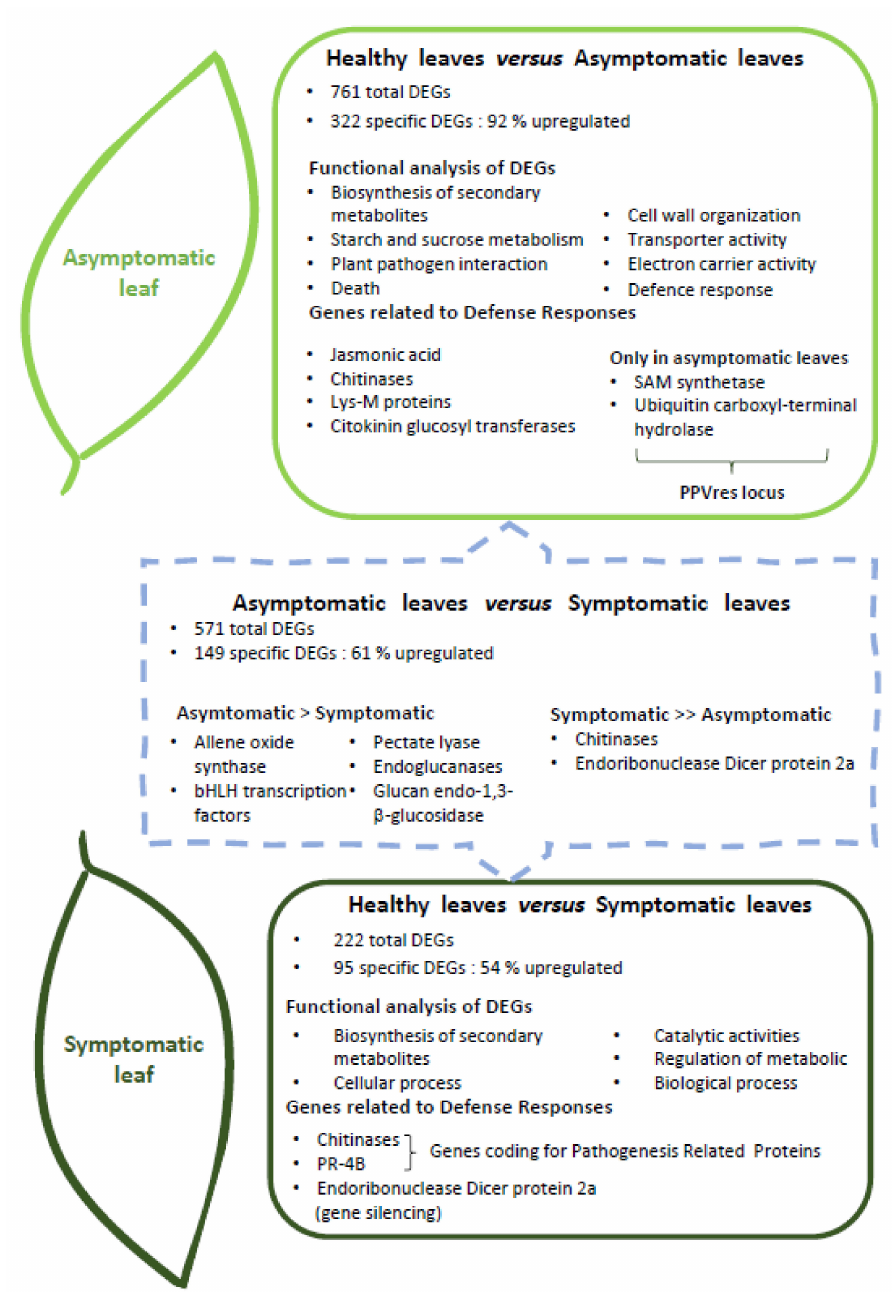
Figure 2. Principal modifications at transcriptomic level after PPV infection in both types of infected leaves: symptomatic and asymptomatic. The information shown in this figure is based on a study by Rubio et al. [20]. DEGs: differentially expressed